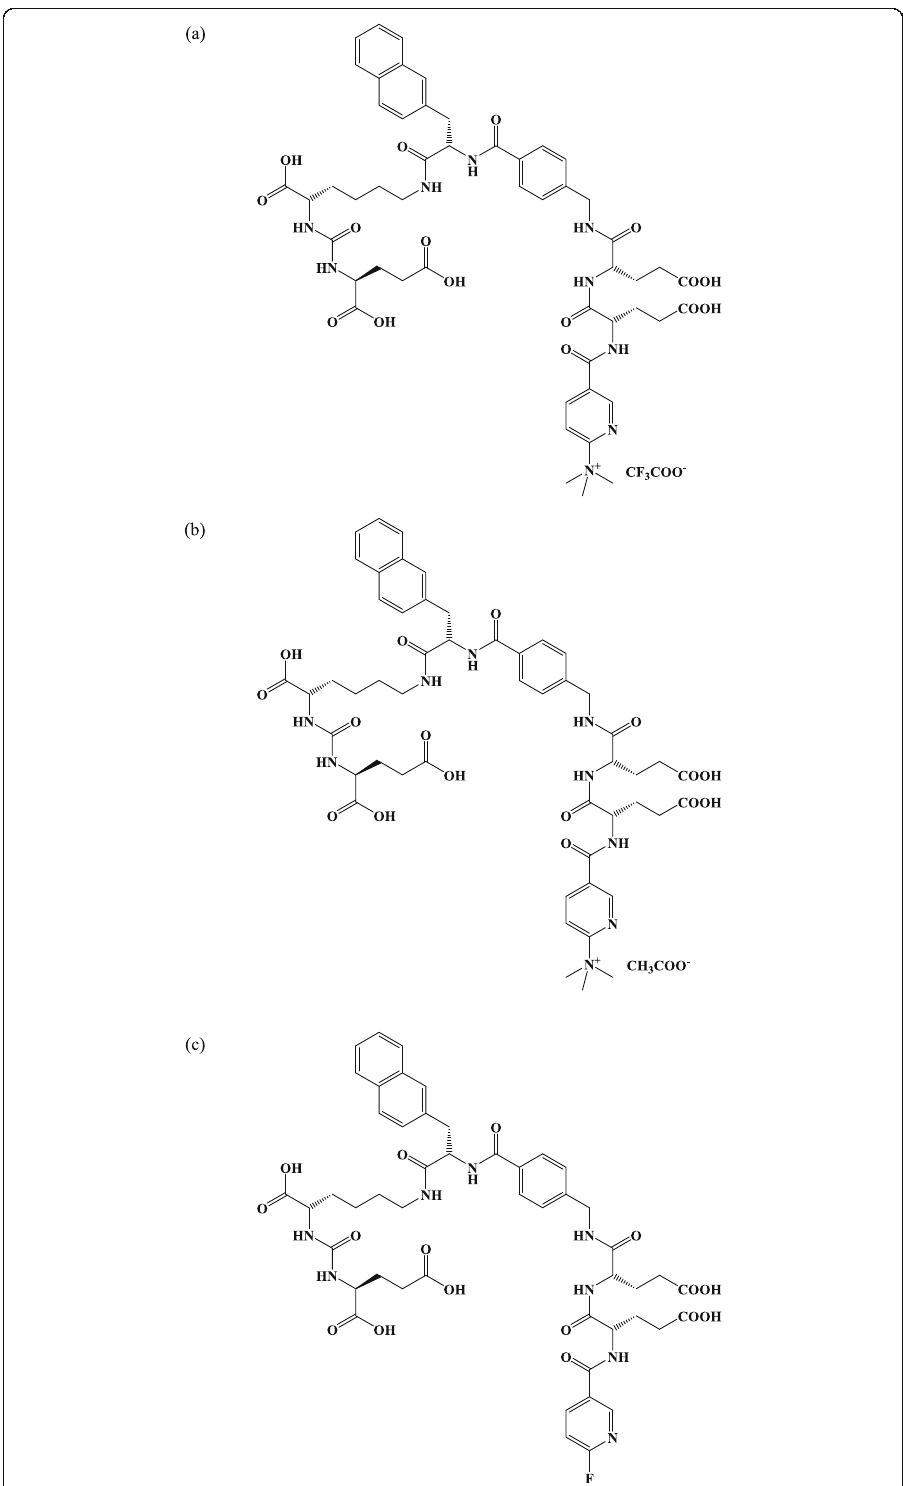
Fig. 1 Structures of the two types of precursors and the reference standard of [ 18 F]PSMA-1007. The precursor for direct radiolabeling was trifluoroacetic acid (TFA) salt ( a ) and acetic acid (ACE) salt ( b ) of the precursor compound bearing tri-methyl ammonium as the leaving group. The reference standard of [ 18 F]PSMA-1007 is shown ( c